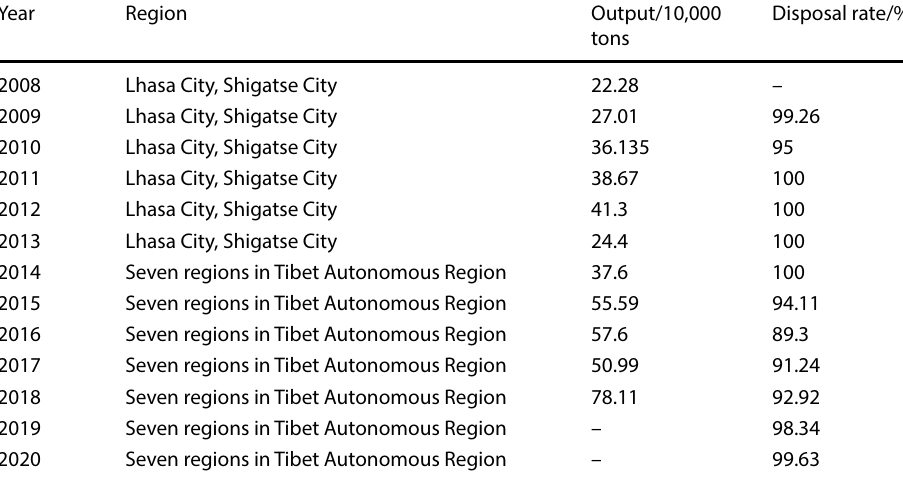
These data are from the Tibet Daily digital newspaper and Department of environmental protection of Tibet Autonomous